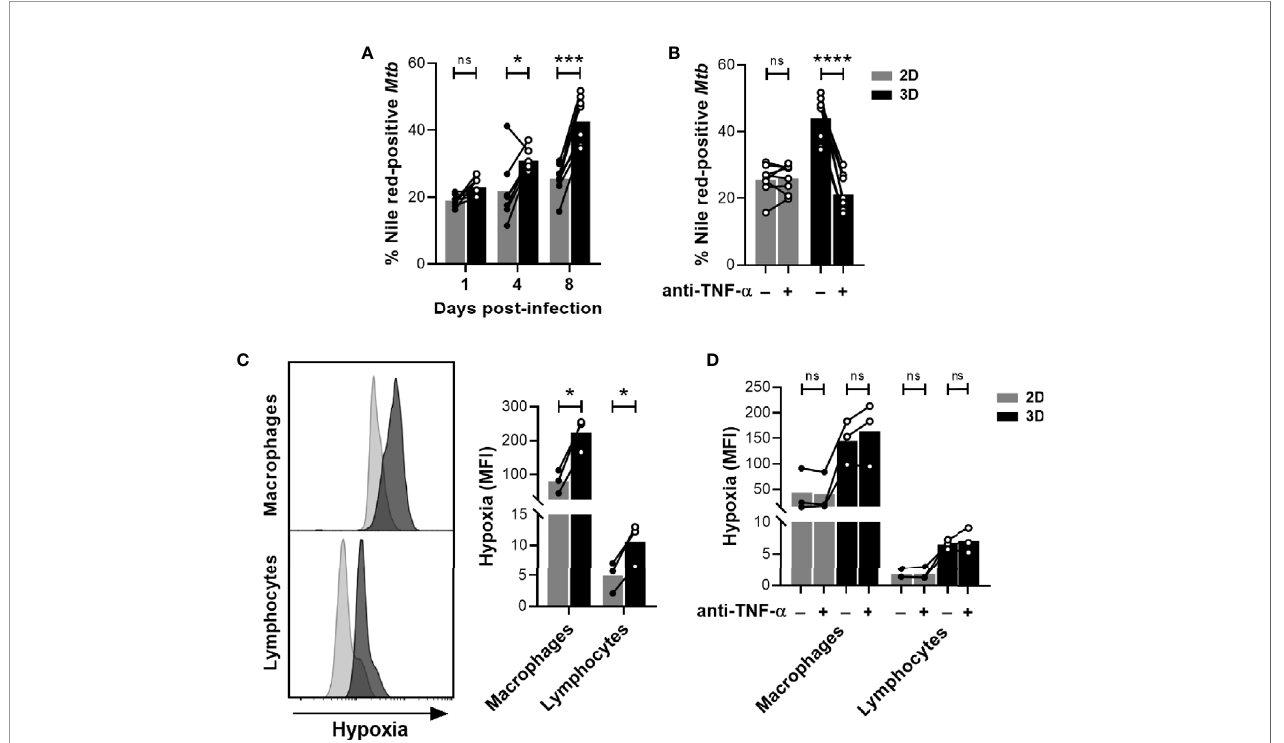
FIGURE 4 | The presence of an ECM induces hypoxia and promotes Mtb dormancy. (A, B) Proportion of dormant-like Mtb quanti fi ed by fl uorescence microscopy upon dual staining with auramine-O and Nile red. (B) On day 4 post-infection, in vitro granulomas were treated with the anti-TNF- a antibody adalimumab (+) or an isotype control ( – ). Proportion of dormant-like Mtb was quanti fi ed after four days of treatment (day 8 post-infection). (C) On day 7 post-infection, hypoxia was evaluated by fl ow cytometry using a fl uorescent probe. (D) On day 4 post-infection, in vitro granulomas were treated with the anti-TNF- a antibody adalimumab (+) or an isotype control ( – ). Flow cytometry analysis of hypoxia using a fl uorescent probe was performed after four days of treatment (day 8 post-infection). Circles represent the value for each individual donor, lines connect results from the same donor, and bars indicate mean values of eight (A, B) or three (C, D) donors. Statistical analysis was performed using two-way repeated measures ANOVA and Sidak ’ s multiple comparisons test. ns, non-signi fi cant; * p < 0.05; *** p < 0.001; **** p <